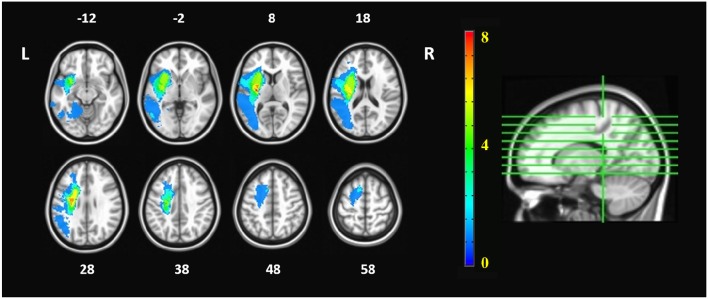
Lesion distribution of stroke patients. The orange numbers in the color bar represented the number of patients who had lesions in the corresponding areas. The white numbers beside the axial images represent the slice number in z coordinate (in mm). The imaging datasets of patients with right hemispheric lesions were flipped, so that the left hemisphere is the ipsilesional hemisphere whereas the right hemisphere is the contralesional hemisphere.